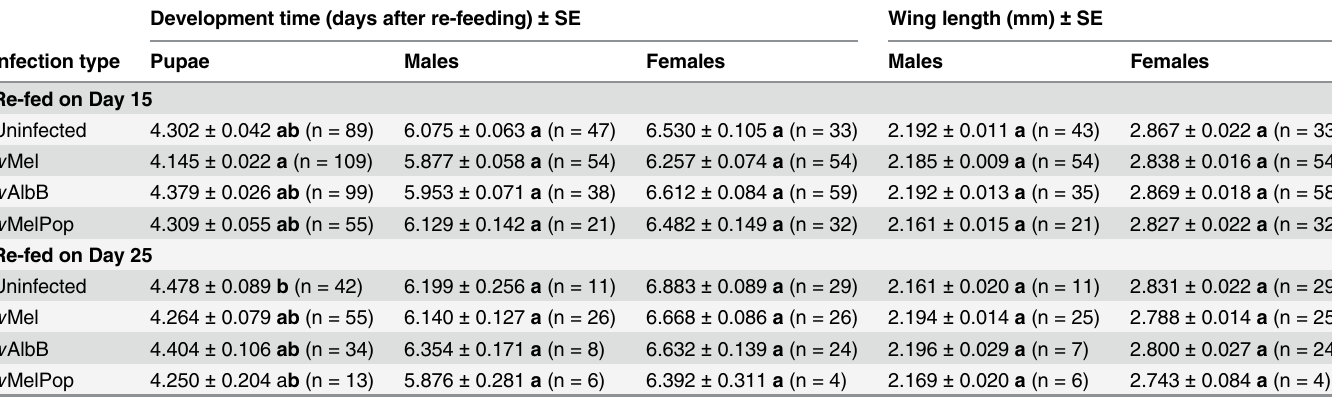
taken for larvae to reach pupation or adulthood after re-feeding. Within a column, values with the same letter in bold are not signi fi cantly different from each other ( P > 0.05, by Tukey ’ s honest signi fi cant difference